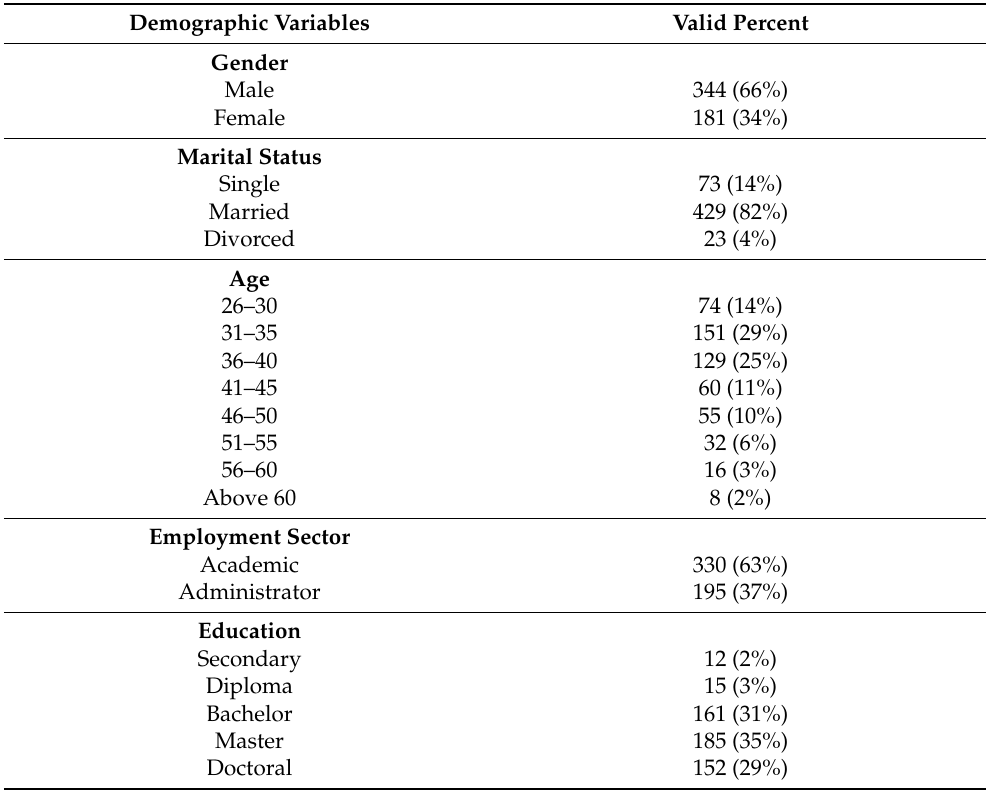
Table 3. Respondents’ Demographic